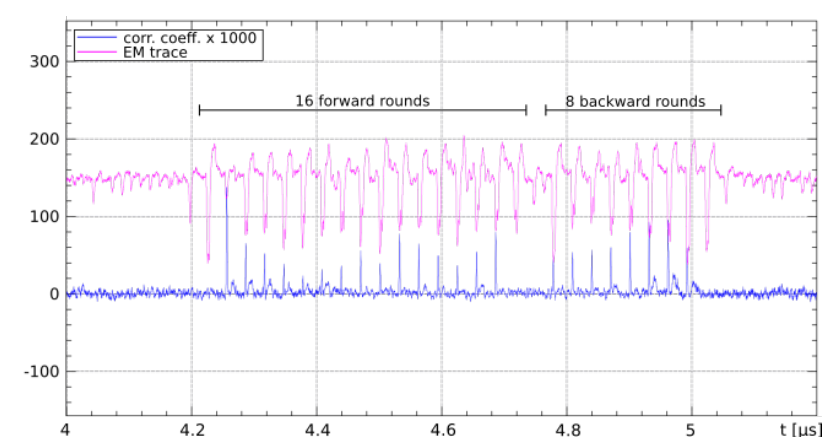
Figure 11: Zoom into EM measurement of one DES execution at a manually selected position measured with a 500 µm diameter probe is shown in pink. The correlation coefficient of a CPOI leakage test for 7 bit XOR templates is shown in blue, scaled up by a factor of 1000 (values ranging up to ≈ 0 . 15). The DES rounds are